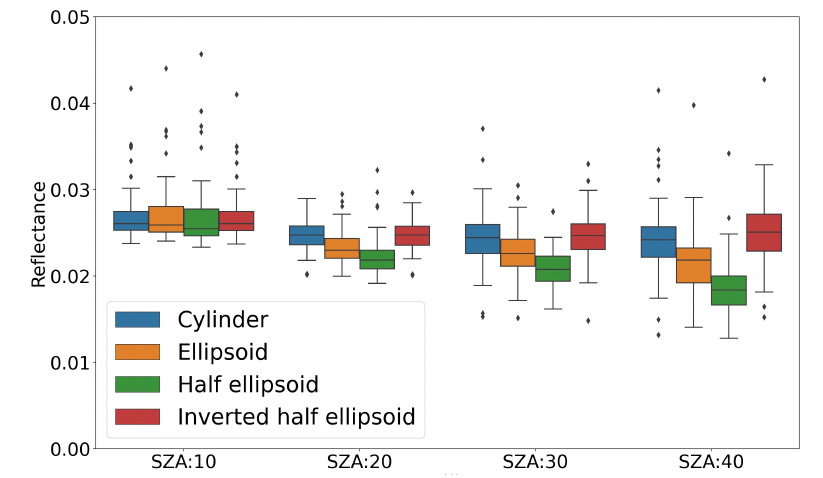
Figure 7. Reflectance simulation results for the same SZA with different canopy shapes. X -axis is SZA and y -axis is reflectance.